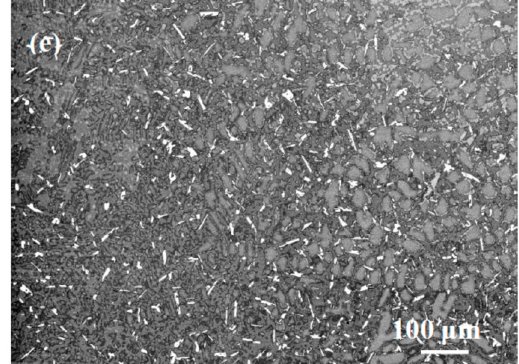
Figure 5. Typical backscatter electron images of the alloy ZF9: ( a – c ) top, bulk and bottom areas of the as cast alloy ZF9-AC; ( d ) the bulk area and ( e ) the top area of the heat-treated alloy ZF9-HT (1400 ◦ C / 100 h). In ( e ) the phase exhibiting white contrast is HfO 2 . Table 4. Lattice parameter (Å) of the Nb ss in the alloys ZF6 and ZF9.